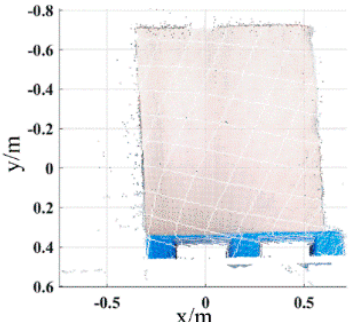
Figure 13. Pallet template point cloud and original ground scene point cloud.